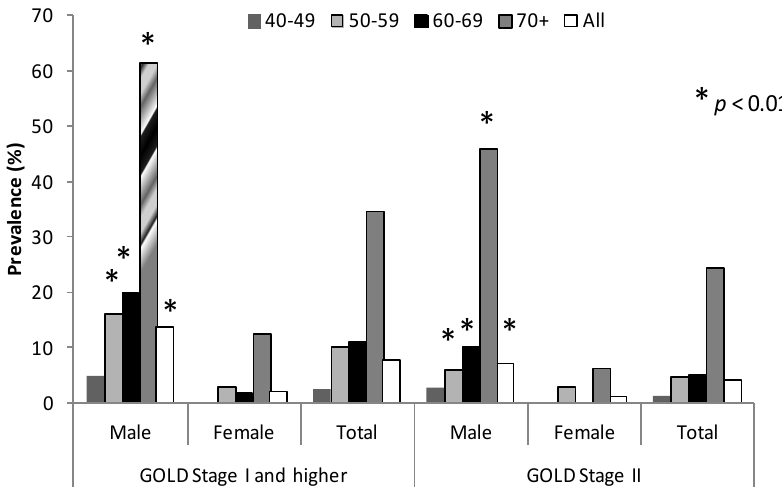
Figure 2. Prevalence of COPD (GOLD stage I and II COPD) by gender and age groups.